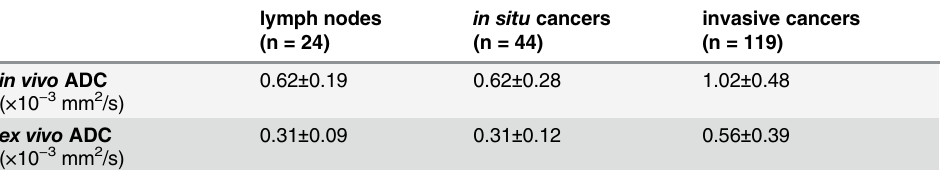
Table 2. The average in vivo and ex vivo ADC values (mean ± standard deviation) for lymph nodes, in situ cancers, and invasive